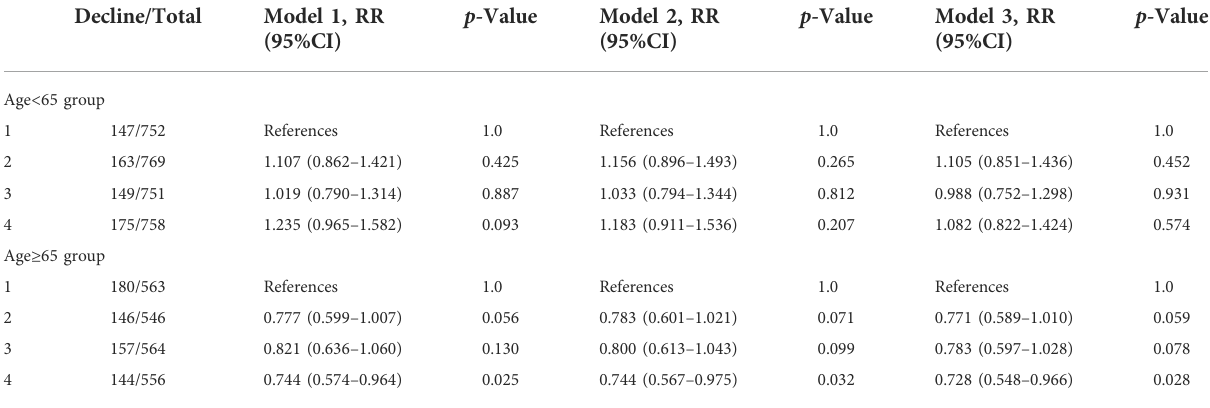
TABLE 2 Risk of renal function decline for adjusted dietary vitamin B3 intake quartile groups.